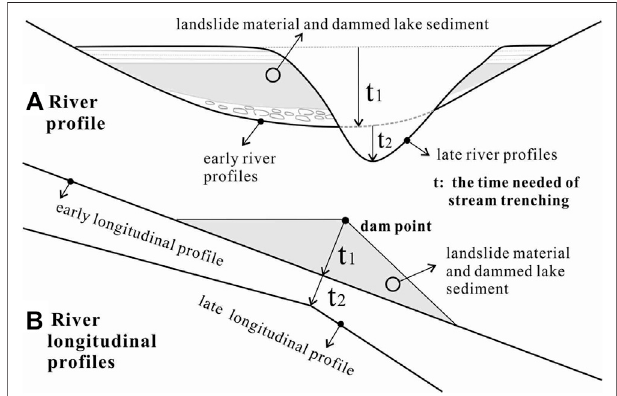
FIGURE5| Aconceptualmodelaboutthechangesbetweenriverpro fi le and river longitudinal pro fi le after the formation of a dammed lake (Assuming that the unconsolidated lacustrine strata will be cut through a very short period, t1 should be a short time during the stage of dam-break).